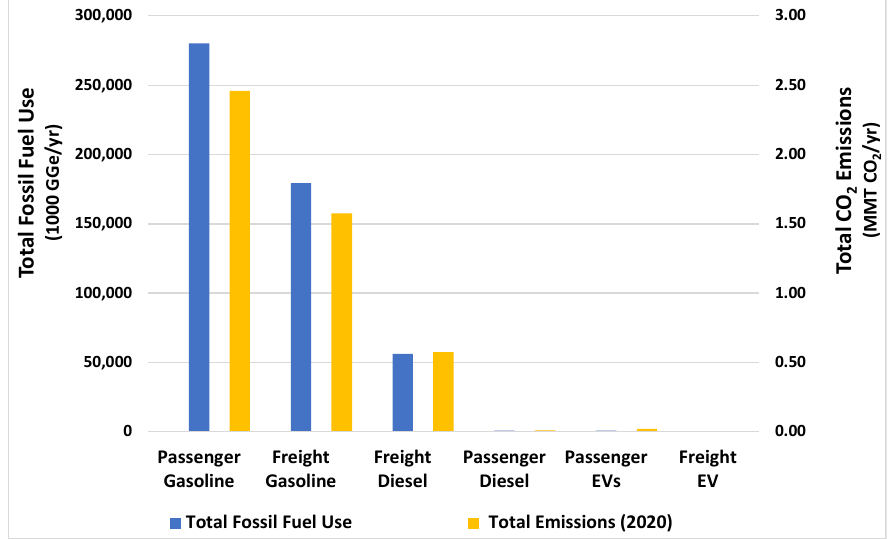
Figure 4. Total annual fossil fuel use by all vehicles on Oahu in 2020 ( blue bars , left axis ), and total annual CO 2 emissions ( yellow bars , right axis ).